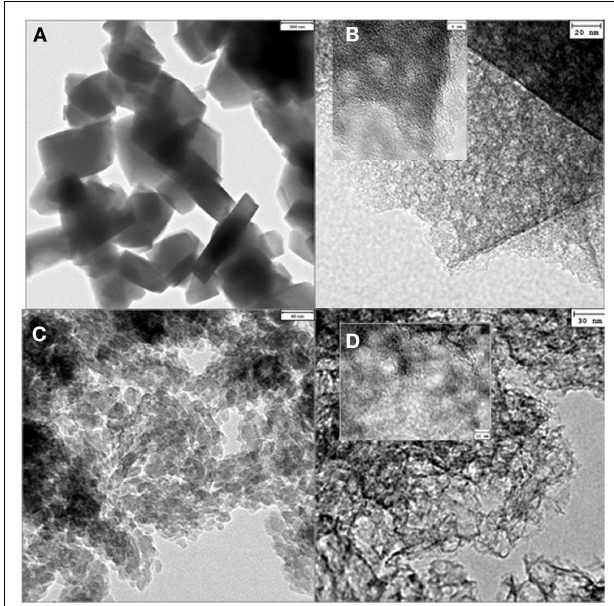
FIGURE 8 |TEM micrographs of theY zeolite,bar length:300nm (A) and L-Y-700 carbon, bar length: 20nm (inset: 5nm) (B); β zeolite, bar length: 40nm (C) and L- β -900 carbon, bar length: 30nm (inset 10nm) (D) .